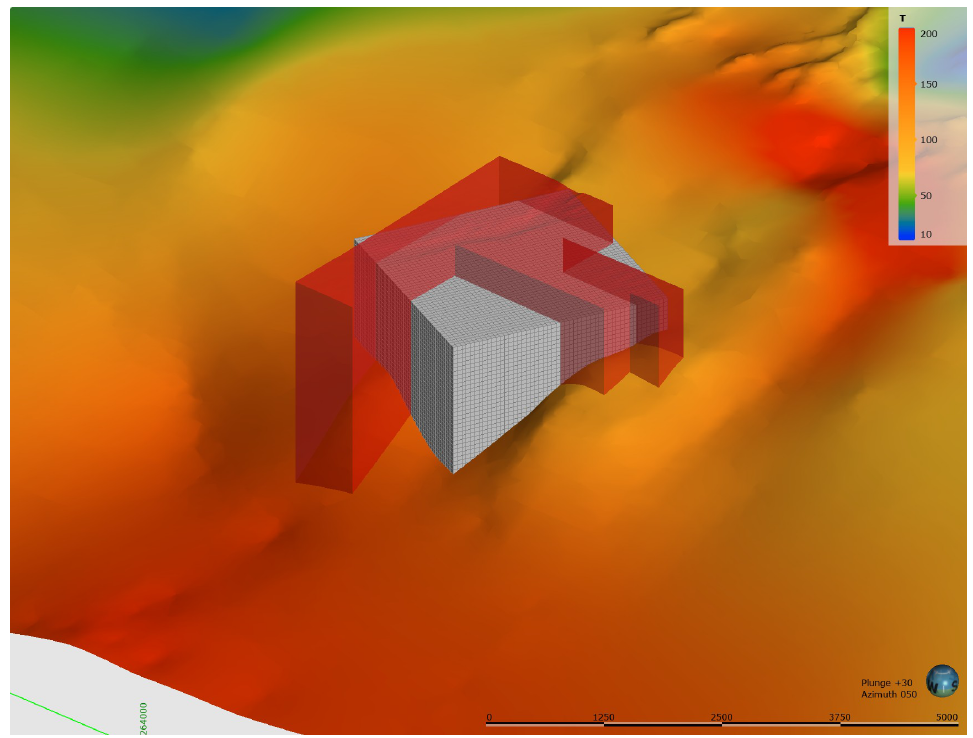
Figure 3. Native state model domain (gray box) shown in relation to the full extents of the FORGE site (red shape) within the earth model domain. Surface shown is the top of the granitoid with the estimated temperature draped over the